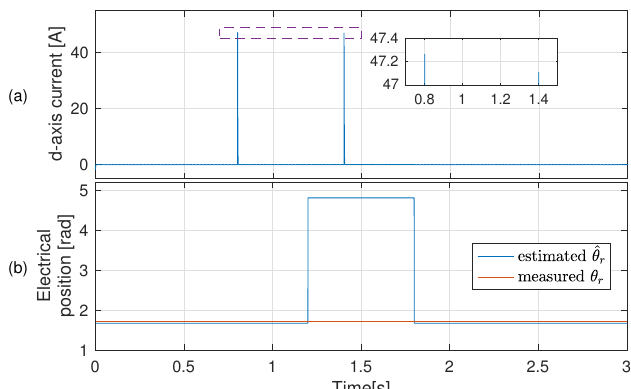
Figure 17. Conventional saturation-based rotor polarity detection.